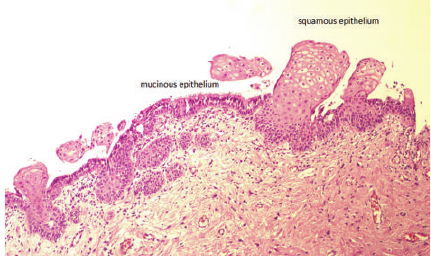
Figure 4: Cyst is lined by columnar mucin producing epithelium and squamous